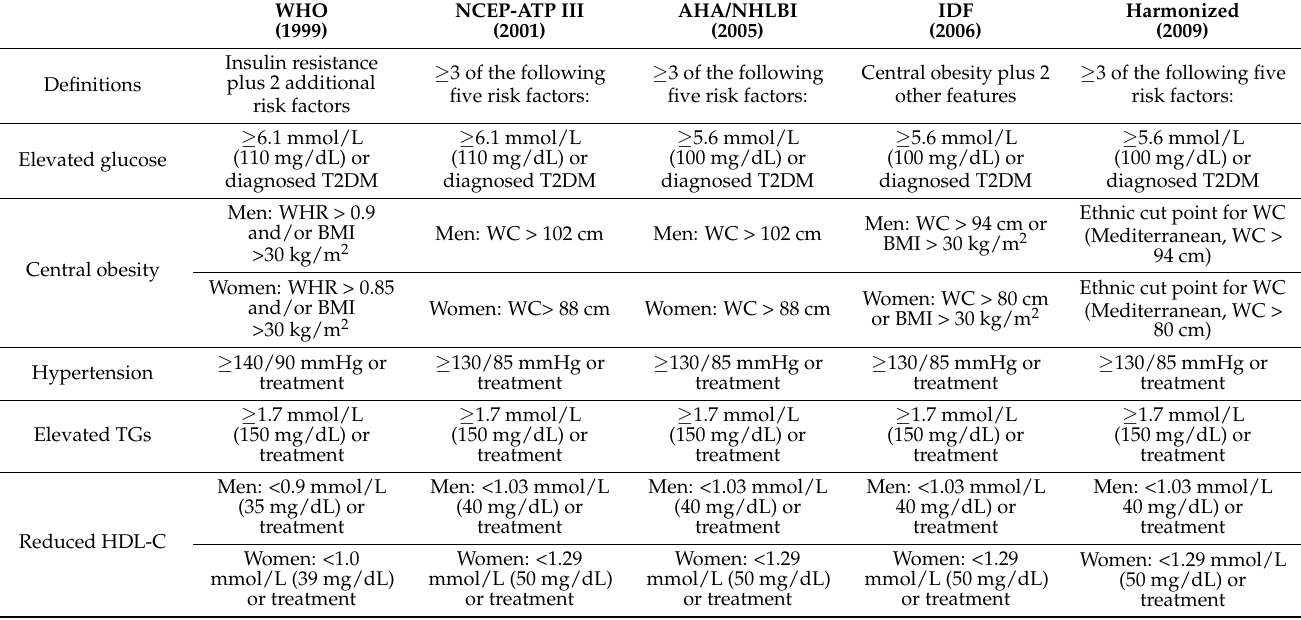
Table 1. The WHO, NCEP ATP III, AHA/NHLBI, IDF, and Harmonized definitions of metabolic